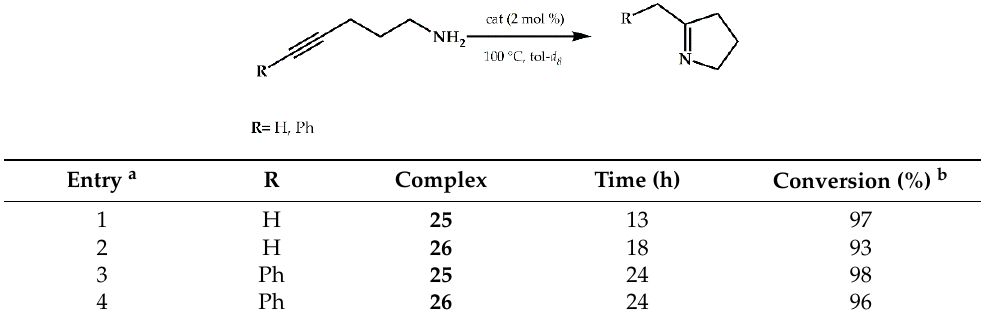
a Reaction conditions: 0.2 mmol of substrate, 2 mol% of [cat.], 2.2 mol% of NaBAr F , 0.6 mL of toluene-d Young’s NMR tube, 100 ◦ C. b Conversions were determined by integration of the product resonances relative to the substrate Table 9 . Gold-catalyzed intermolecular hydroamination reactions of phenylacetylene with Ar-NH 2 .